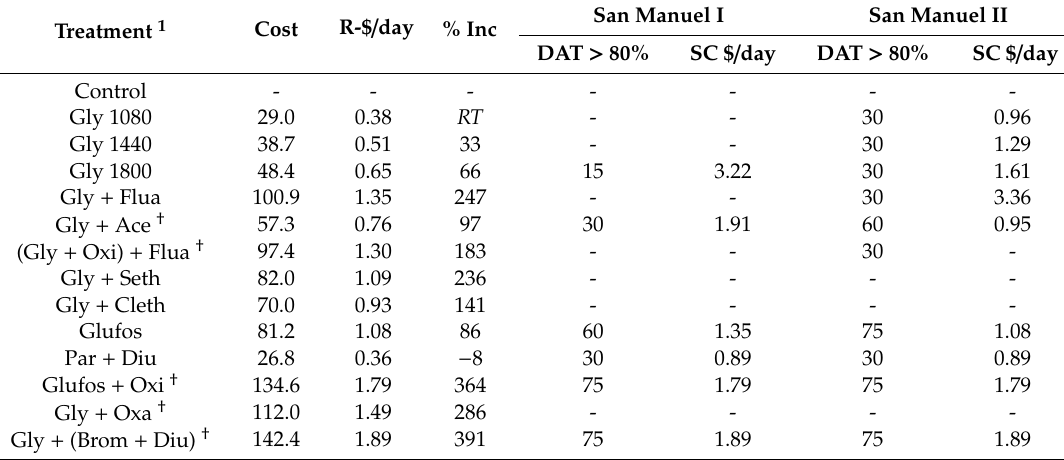
Table 4. Cost of herbicide treatments (Cost), relative daily cost considering 75 days of weed control (R-$ / day ha − 1 ) *, percentage of cost increase (% Inc) * in relation to the representative treatment